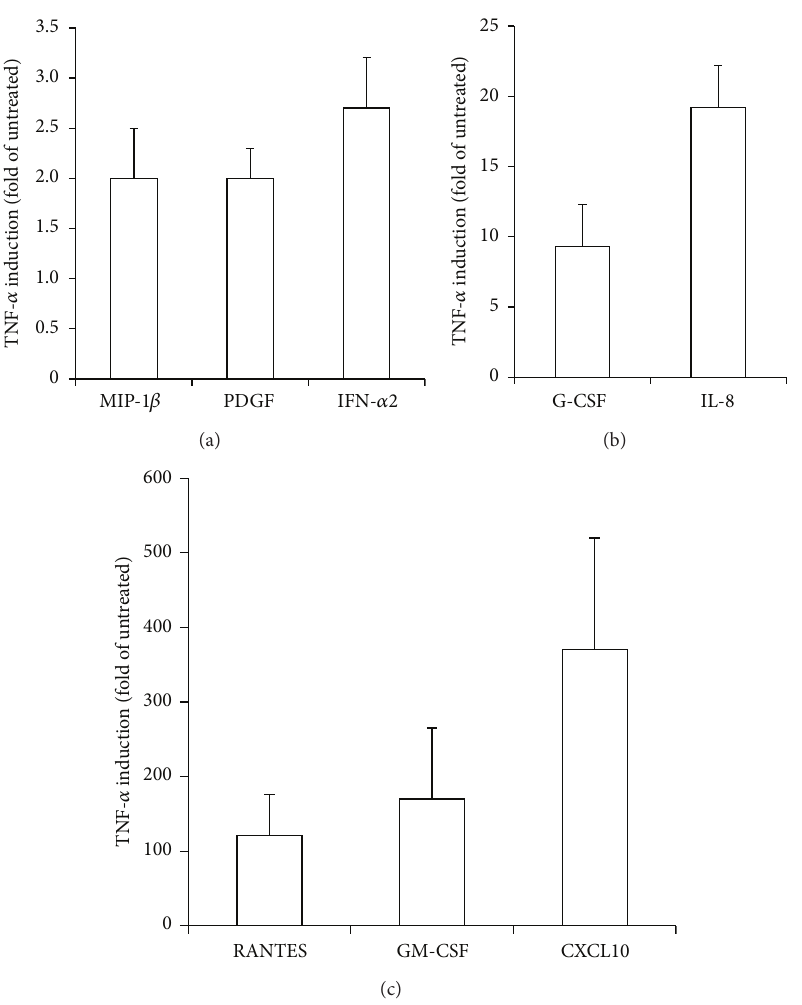
Figure 1: Cytokines/chemokines in vitro release by pathological VEC in response to TNF- 𝛼 . Endothelial cells were exposed for 24 hours to TNF- 𝛼 (5ng/mL) before analysis of cytokines/chemokines release on culture supernatants. Results are expressed as fold of induction with respect to untreated cultures (set to 1). Only cytokines/chemokines showing fold of induction ≥ 2 have been reported. Data are means ± SD of results obtained in VEC from all CVD